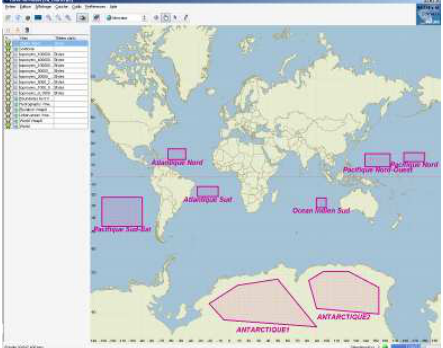
Figure 5: Acquisition zones for ImageQuality Assesment